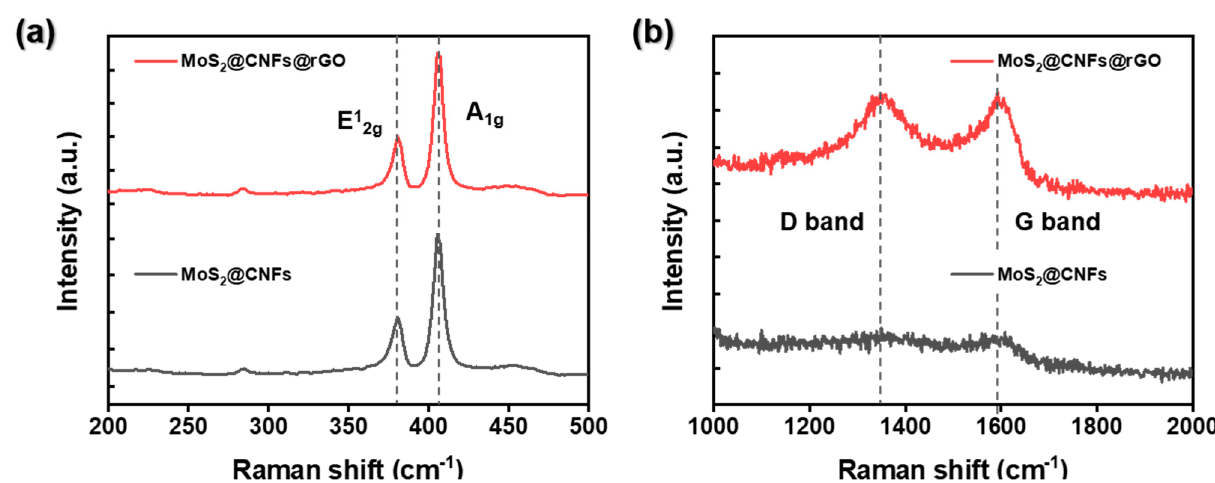
Nanomaterials 2021 , 11 , x FOR PEER REVIEW Figure 4. X-ray diffraction pattern of MoS 2 @CNFs and MoS 2 @CNFs@rGO. Figure 4. X-ray diffraction pattern of MoS 2 @CNFs and MoS 2 @CNFs@rGO.